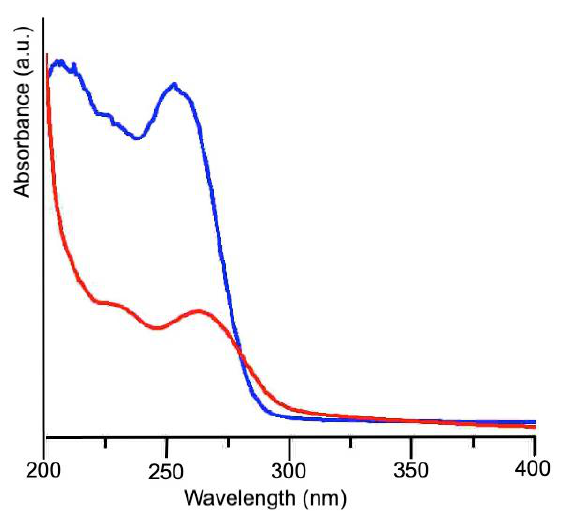
Figure 1. UV-vis spectra of snail slime as received (blue line) and after dialysis (red line).